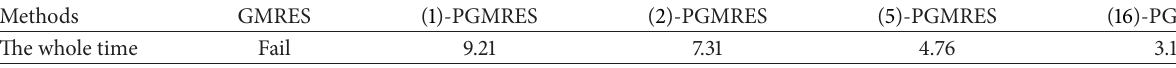
Table 1: Comparison of the computational time in solving the linear system 𝐴𝑥 = 𝑏 in Experiment 2.